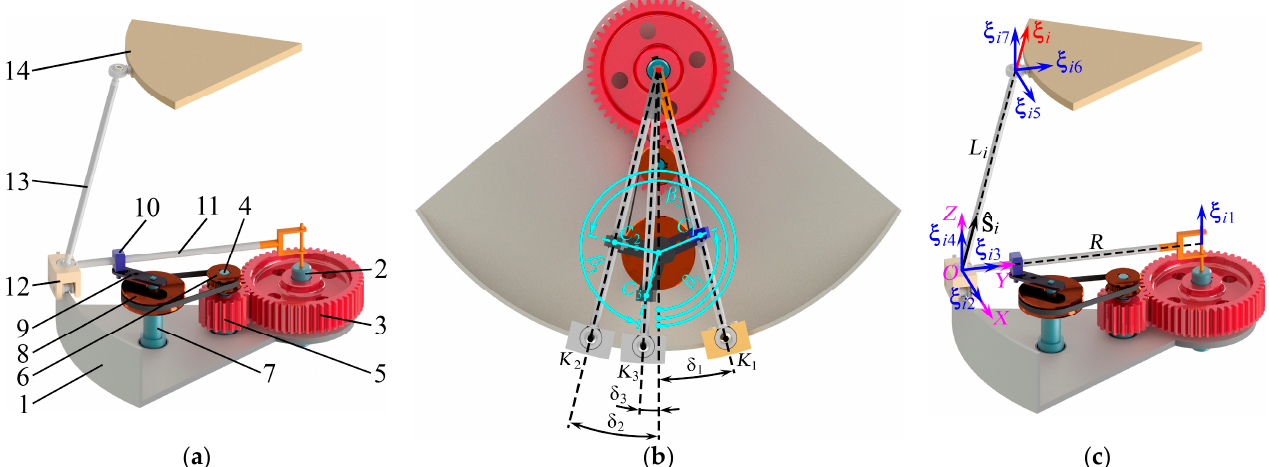
Figure 1. CAD schemes of the single reconfigurable kinematic chain: ( a ) main components: circular guide 1 (fixed link); shaft 2 and wheel 3 (driving link); shaft 4, gear 5 and driving pulley 6; shaft 7, driven pulley 8 and crank 9; slide block 10; swinging arm 11 and carriage 12; leg 13; and platform 14 (output link); ( b ) reconfigurable positions of the chain with carriage displacements δ 1 , δ 2 and δ 3 , corresponding to the crank angles β 1 , β 2 and β 3 with the fixed driving wheel; ( c ) twists for a single kinematic chain and a reciprocal wrench for the chain with the locked drive.